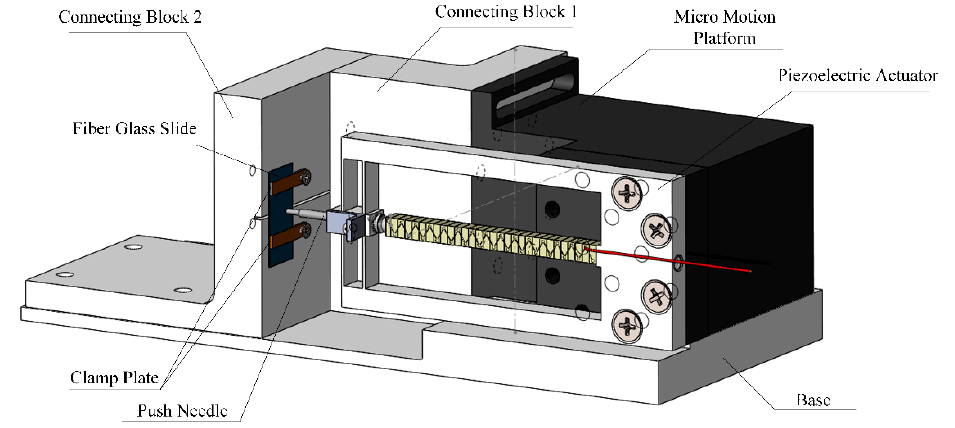
Figure 2. Structure of the push-out system.